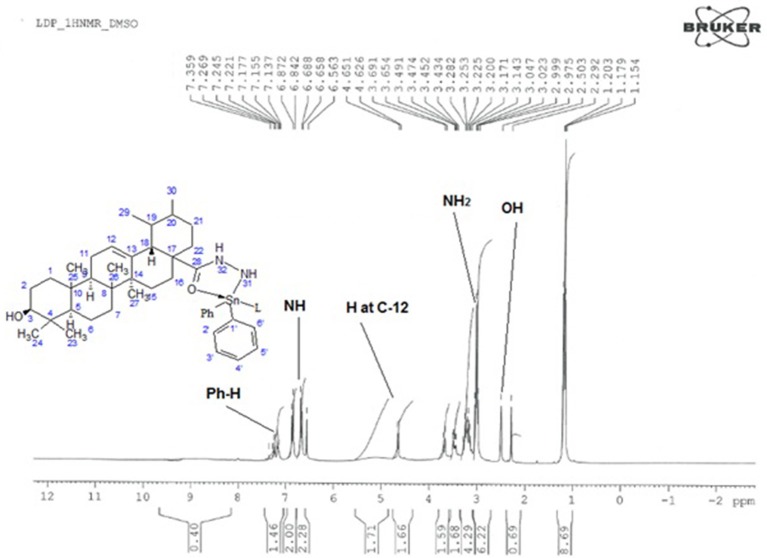
1H NMR Spectrum of Diphenyltin complex.